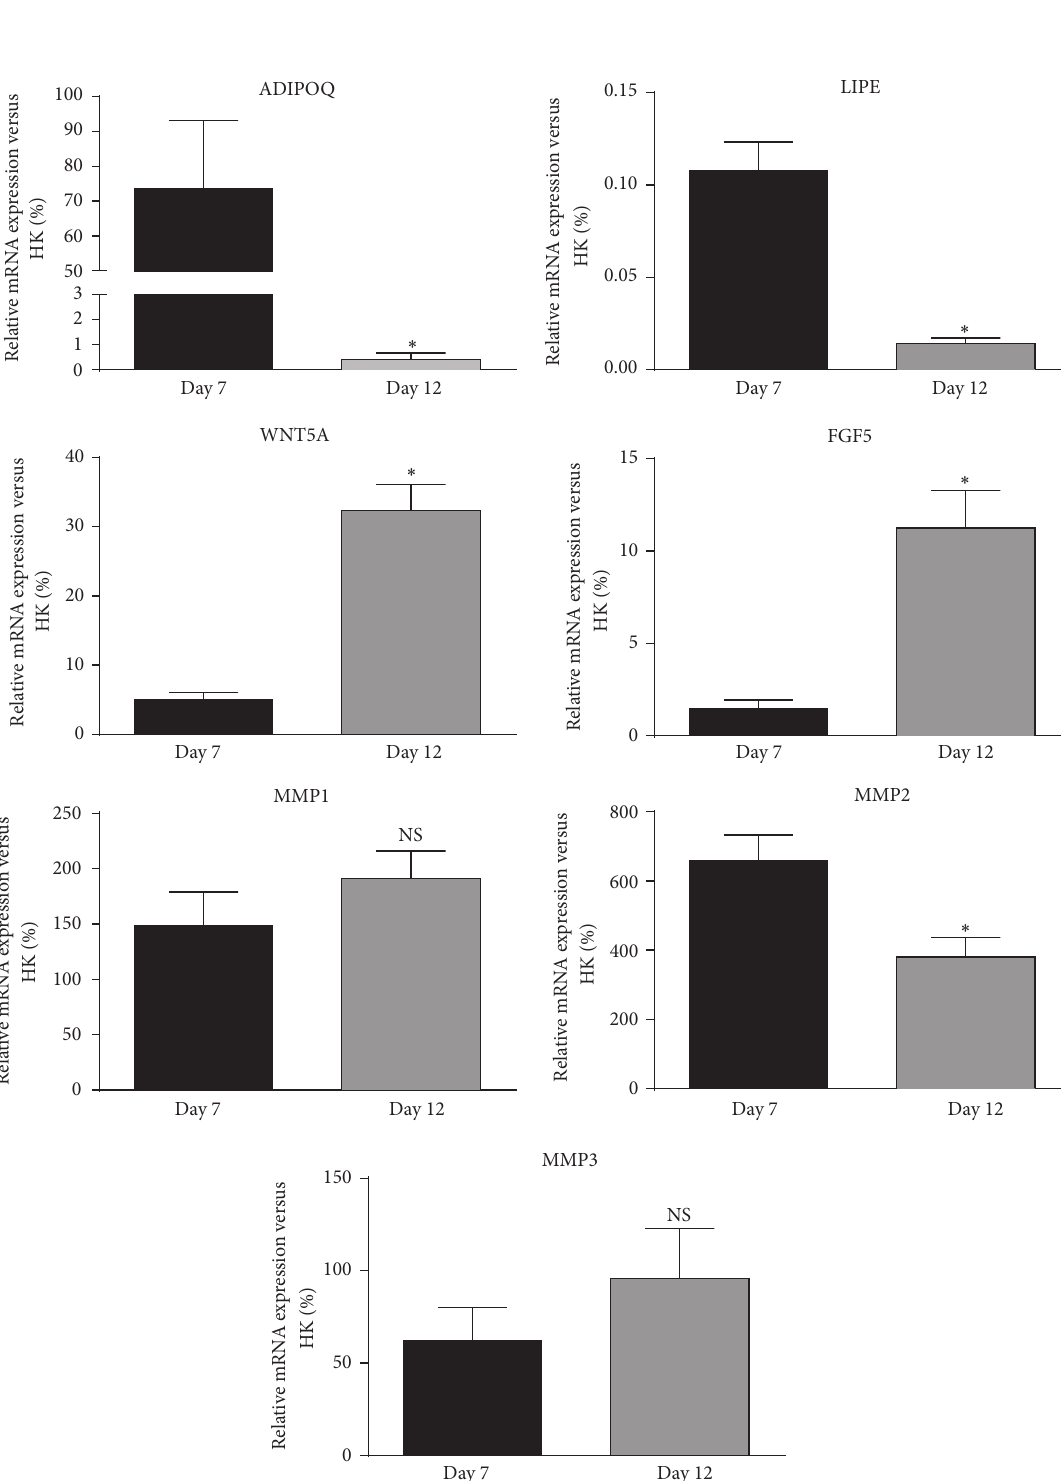
Figure 7: Differences in gene expression at day 7 and day 12 of the dedifferentiation process measured by quantitative RT-PCR. Target gene amplifications were normalized using housekeeping gene expression levels of ATP synthase O subunit (ATP5O). Values are mean ± SEM ( ∗ 𝑃 ≤ 0.05